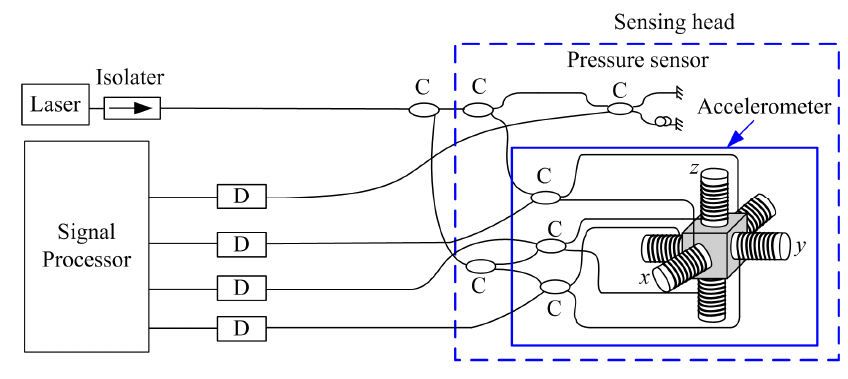
Figure 2. Structure of optical fiber vector hydrophone.